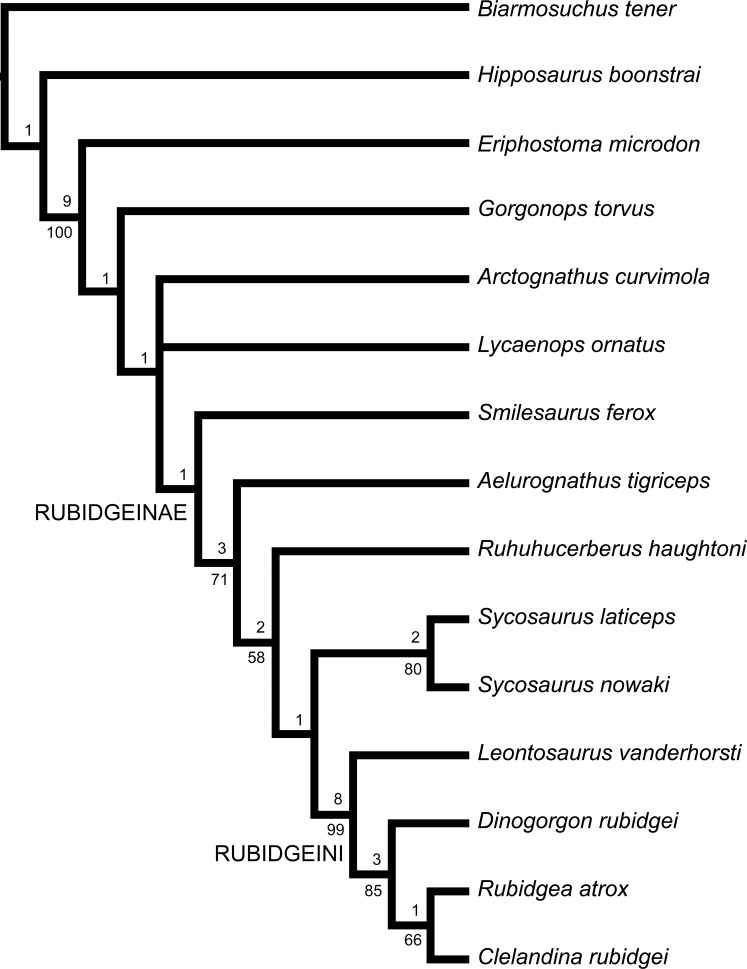
Strict consensus cladogram of rubidgeine interrelationships.Numbers under nodes represent symmetric resampling support, numbers above nodes represent Bremer support.